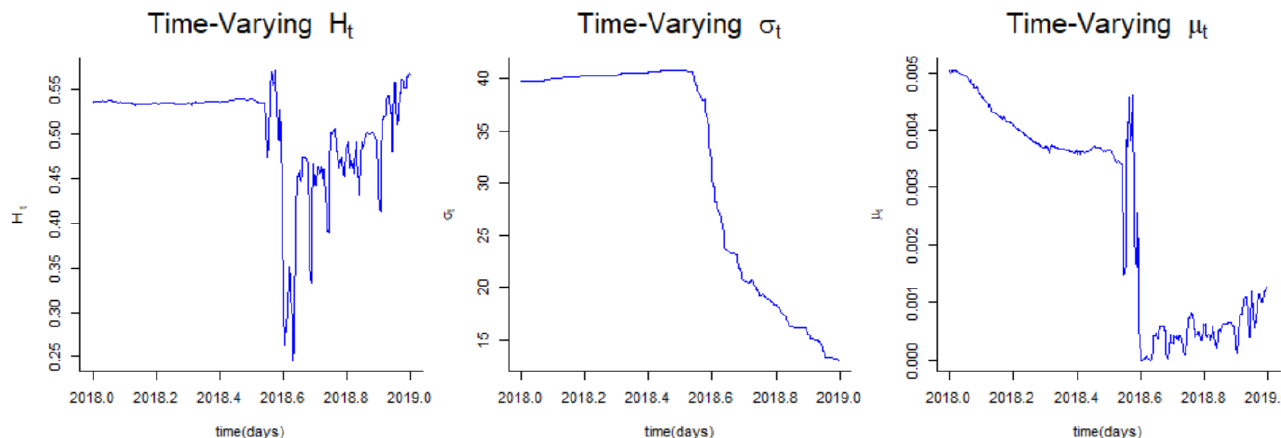
Figure 1. Time-varying parameters.